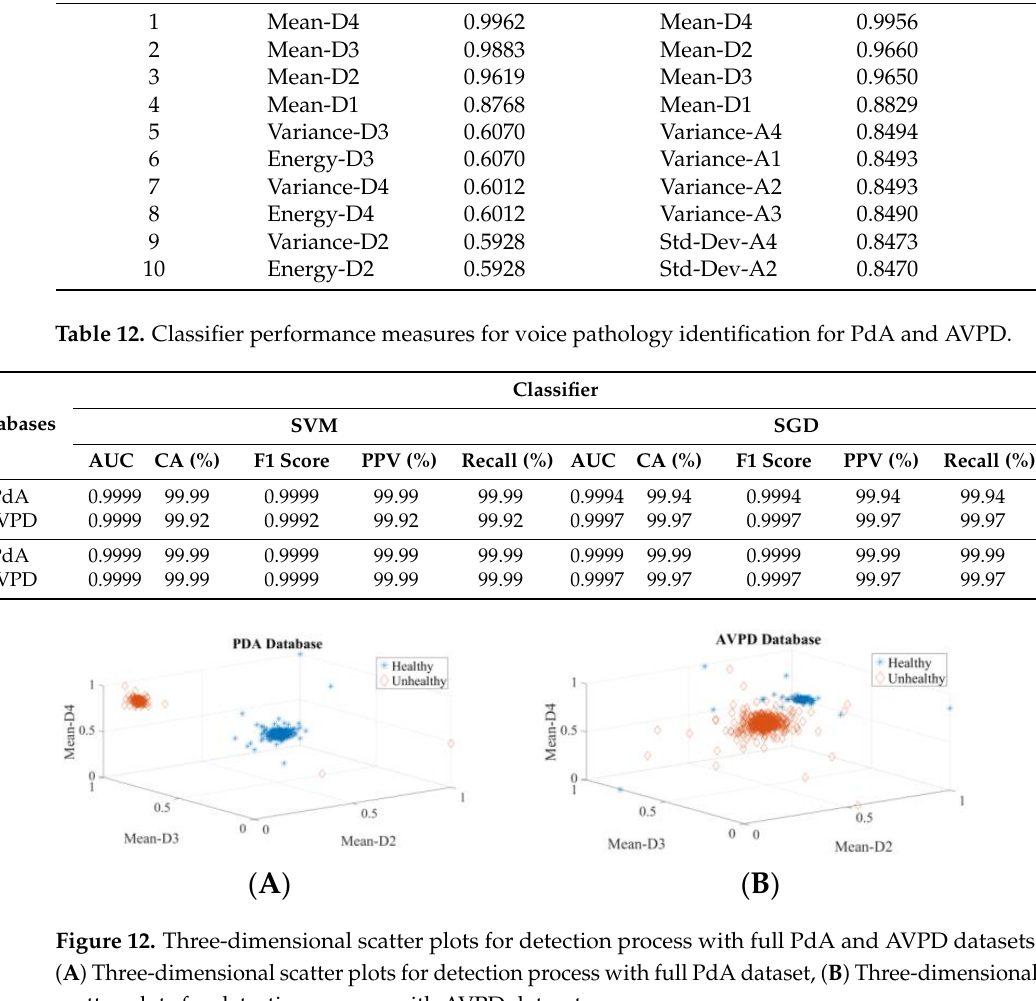
Table 11. Top 10 ranked descriptors with 15 pathologies from PdA and five from AVPD.